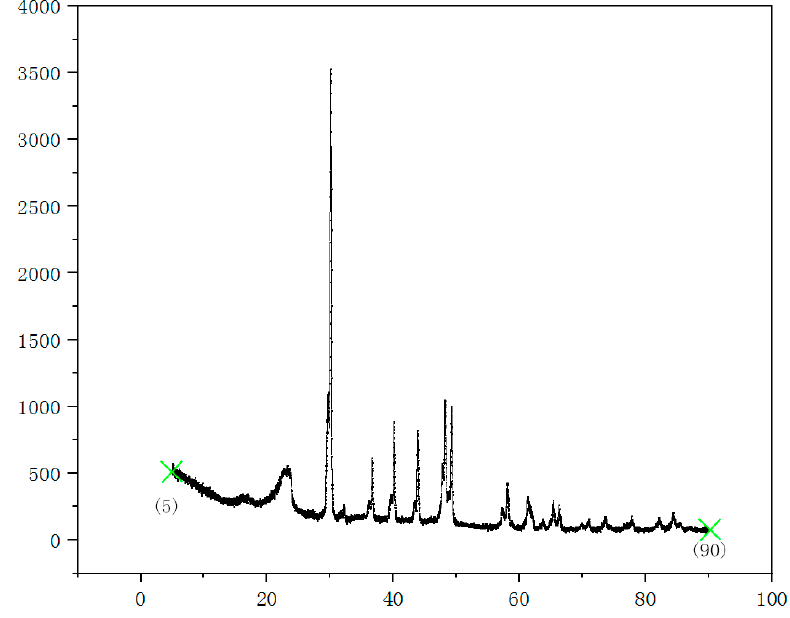
Figure 5. X-ray diffractometry (XRD) pattern of foam materials.